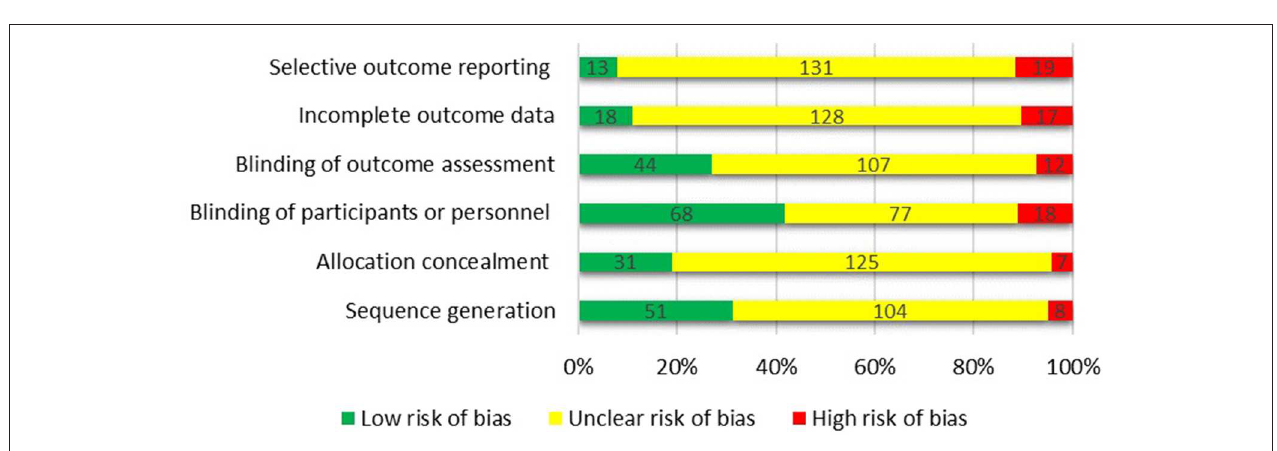
FIGURE 7 | Categorization of included studies.